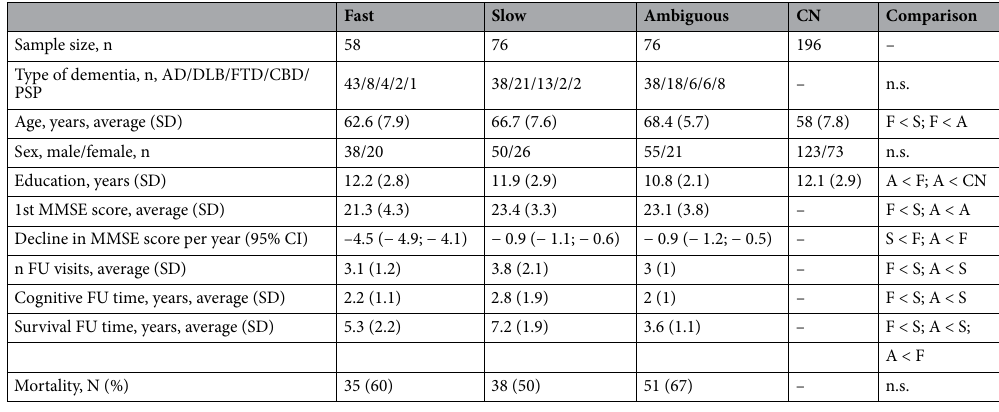
Table 1. Baseline demographics per group. FU follow-up, MMSE Mini-mental state examination, CN cognitively normal, F fast, S slow, A Ambiguous, Comparison group comparison statistics, AD Alzheimer’s disease, DLB dementia with Lewy bodies, FTD frontotemporal dementia, CBD corticobasal degeneration, PSP progressive supranuclear palsy, CI confidence interval, n.s. not significant, dash (–) not